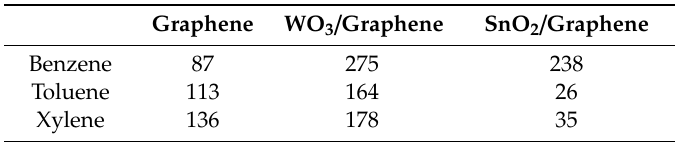
Table 3. Response time (s).